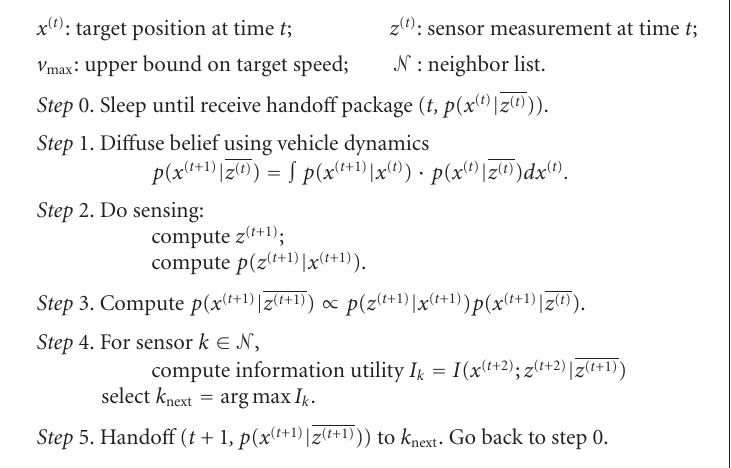
Algorithm 1: Algorithm for IDSQ tracker at each